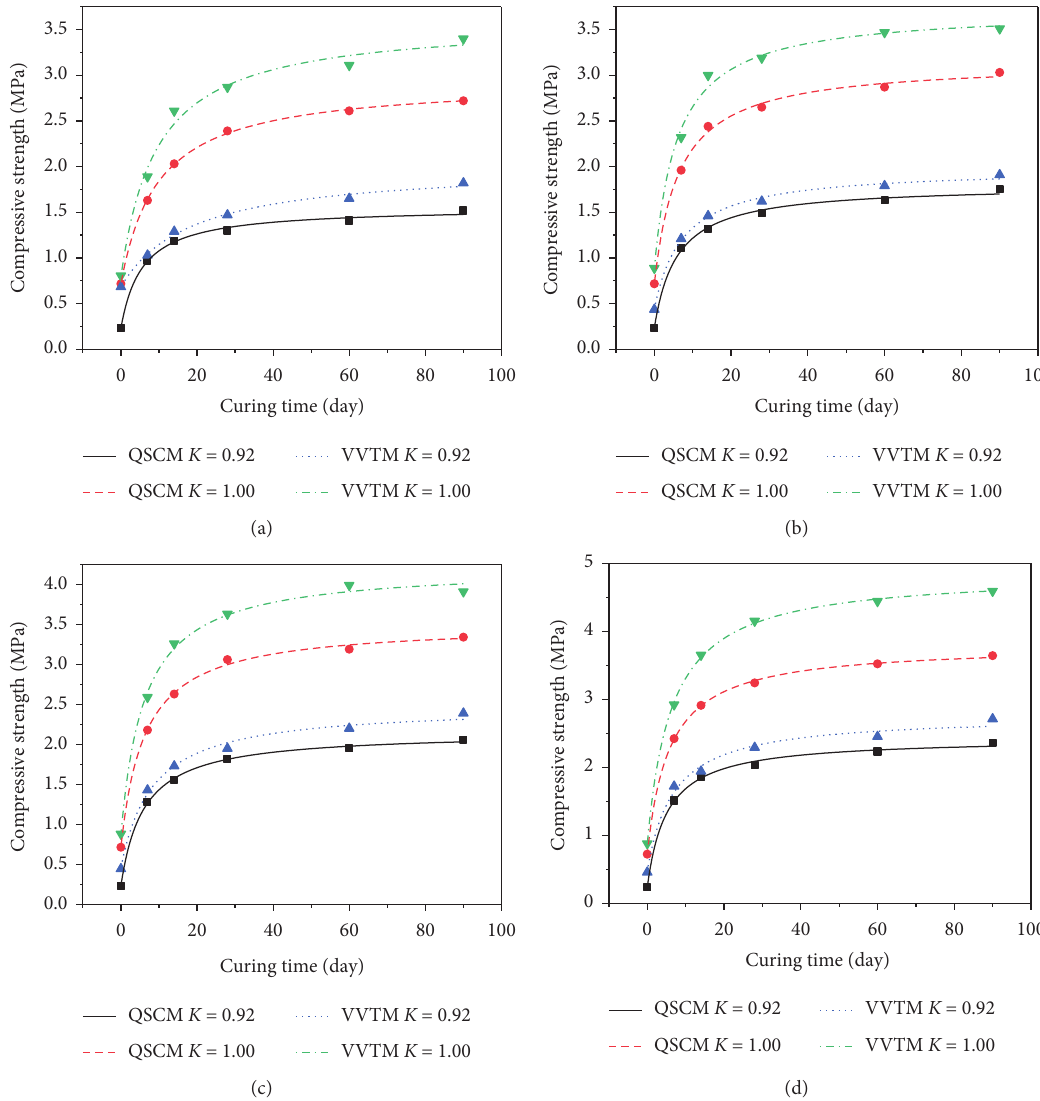
Figure 6: Influence of curing time on UCS of CSL compacted using VVCM and QSCM. (a) Cement content � 3%. (b) Cement content � 4%. (c) Cement content � 5%. (d) Cement content �